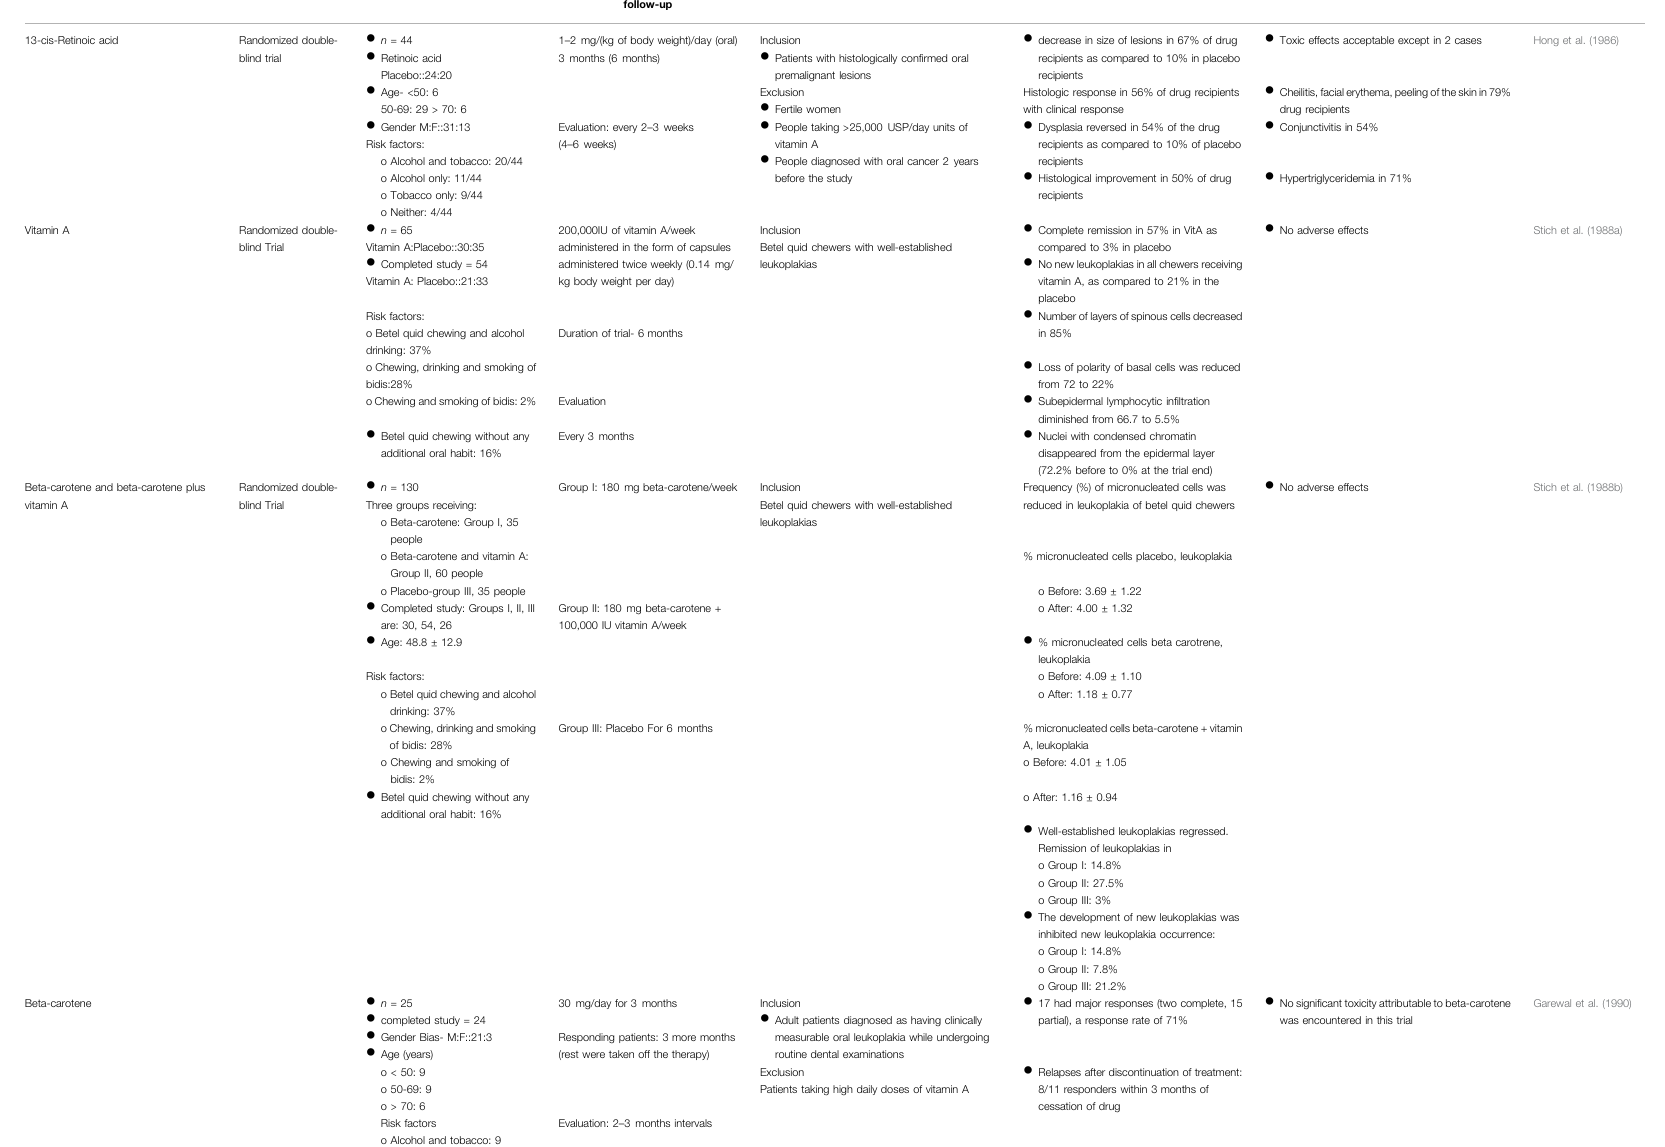
TABLE 7 | Clinical studies in chemopreventive phytochemicals/herbal derivatives against HNC.